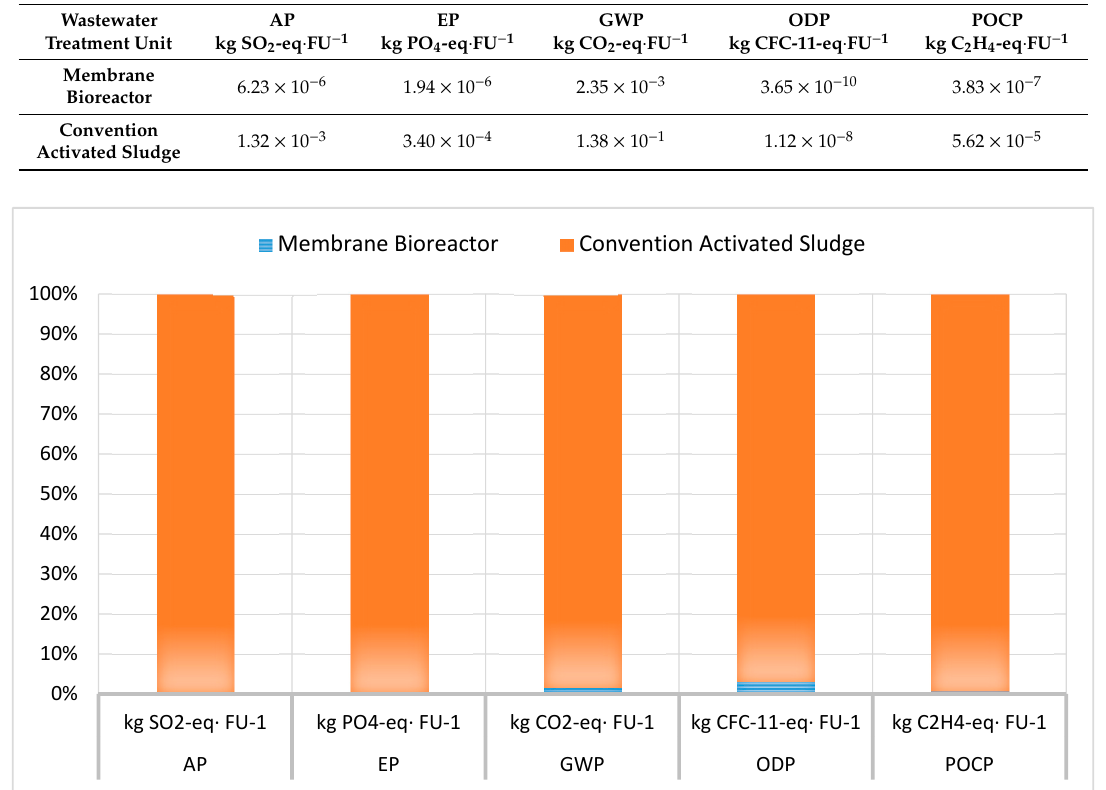
Figure 5. Comparison of the LCIA for the two units with no plant contribution.